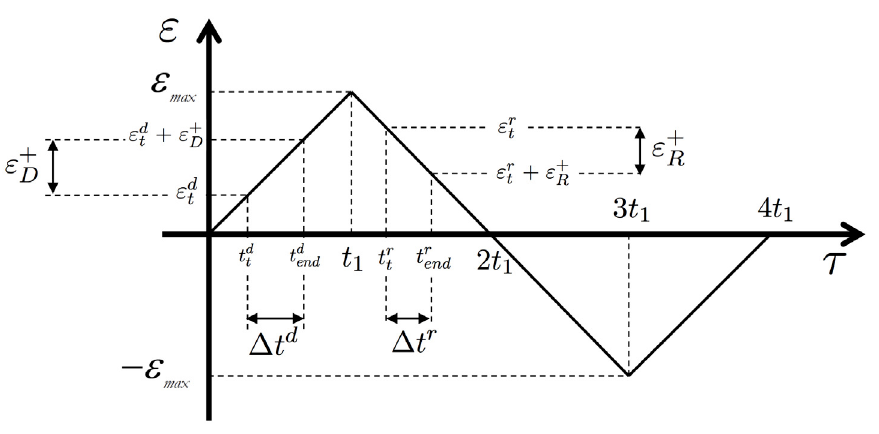
Figure 2: Applied strain  vs. time 